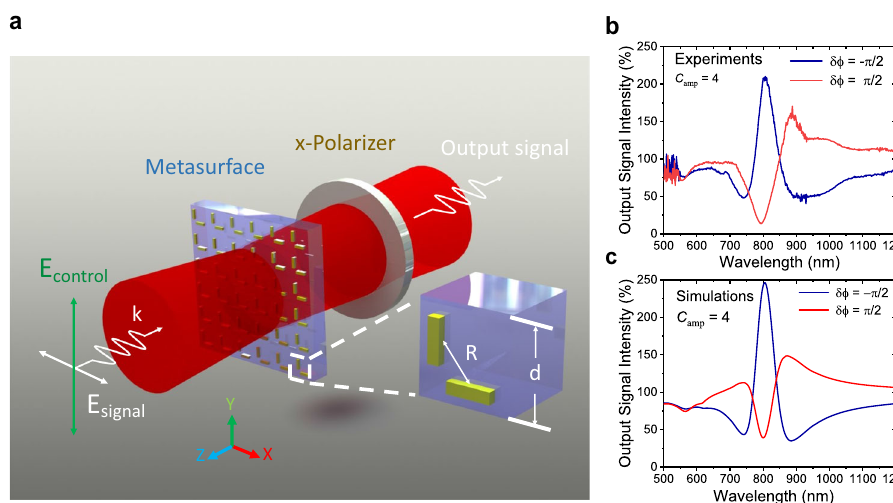
Fig. 3 All-optical nanoswitch based on coherent control of surface plasmons. a Schematic illustration for the modulated output signal intensity of the device under the excitation of an x -polarized signal beam and a phase-delayed y -polarized control beam from a broadband light source. The inset of the fi gure represents the schematic of a single L-shaped meta-molecule as a unit cell of the metasurface with a period of ( d ) and center to center distance ( R ) of nanorods. b , c Experimental and simulated modulated output signal intensity at C amp = 4 with phase differences of ± π /2 between control and signal beam, demonstrating the strong switching presence of speci fi c phase difference between signal and control induce an extraordinary modi fi cation in the resonance pro fi le of the beams. Thus, this energy exchange enhances the output signal horizontal nanoantenna probed by the x -polarized signal beam. This intensity and enables the all-optical switching effect. In order to modi fi cation of the spectral pro fi le of LSPR and induced zero or verify the canalization of energy from control to signal beam, a negative absorption is attributed to the mutual coupling of both decrease in transmission of control beam has been numerically as nanoantennas and the canalization of energy from vertically (control well as experimentally shown with the phase difference δϕ = π /2 in beam) to horizontally (signal beam) oriented nanoantenna in the Supplementary Fig. 1.